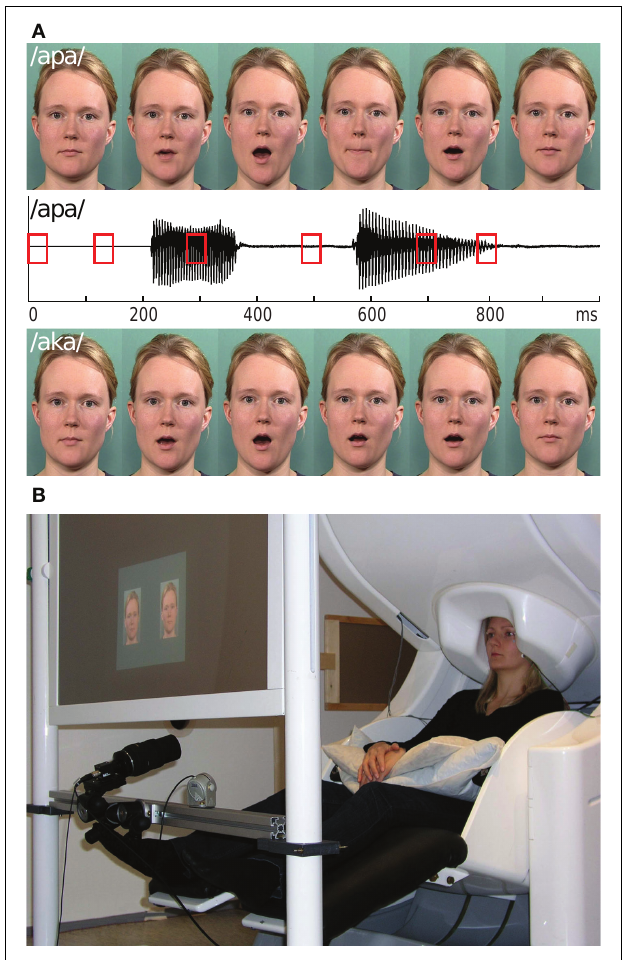
FIGURE 1 | Stimuli and measurement. (A) Auditory /apa/ waveform, and six frames of the corresponding congruent /apa/ and incongruent /aka/ visual stimuli. Red squares on the auditory waveform indicate the time of the corresponding frame shown in the video sequence. (B) An example of the experimental setup. The subject is sitting under the MEG sensor helmet and the visual stimulus is refl ected on the back-projection screen; the eye tracker system is attached to the stand below the